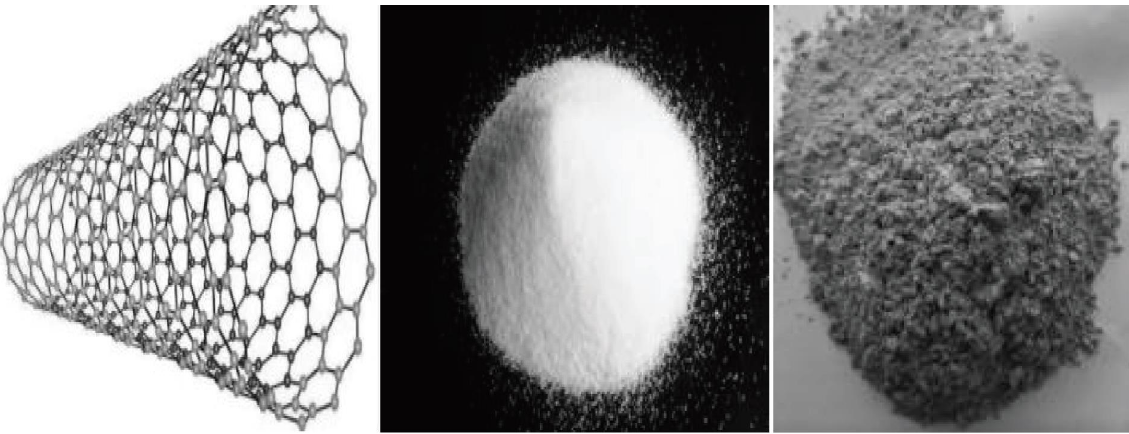
Figure 2: Tree common nanomaterial’s in